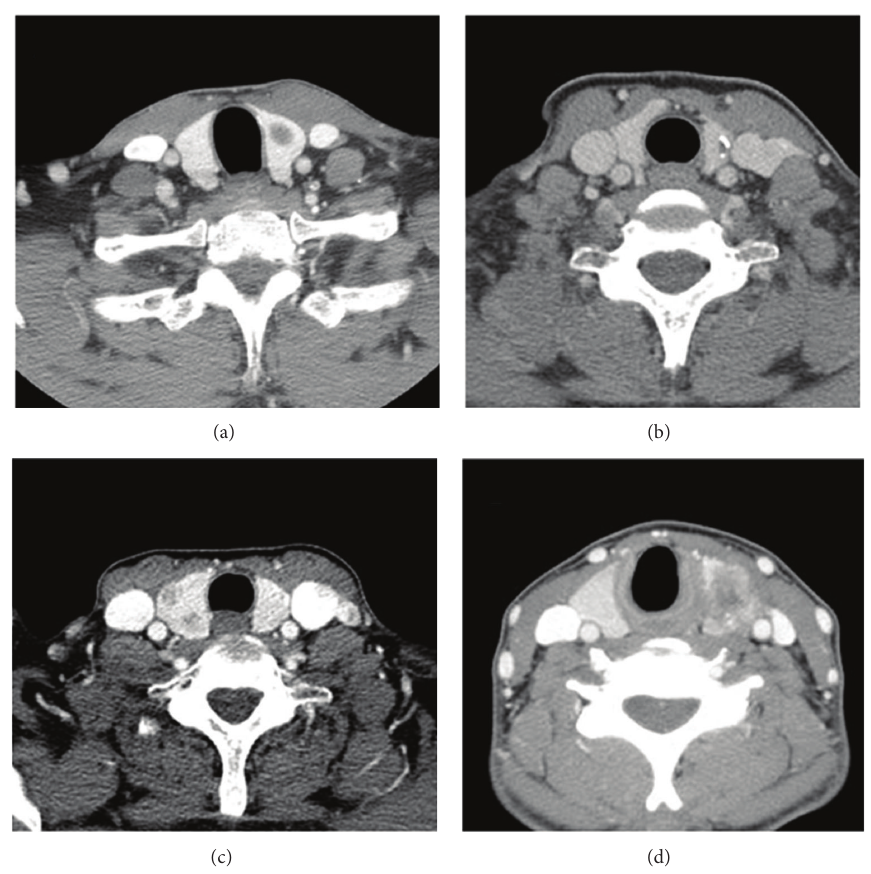
Figure 2: Grouping of thyroid tumor according to computed tomographic findings. (a) Group A: the tumor is completely enveloped by thyroid parenchyma, (b) Group B: the percentage of the perimeter of the tumor that contacted the thyroid capsule is less than 25%, (c) Group C: the percentage of the perimeter of the tumor that contacted the thyroid capsule is 25–50% contact, (d) Group D: the percentage of the perimeter of the tumor that contacted the thyroid capsule is more than